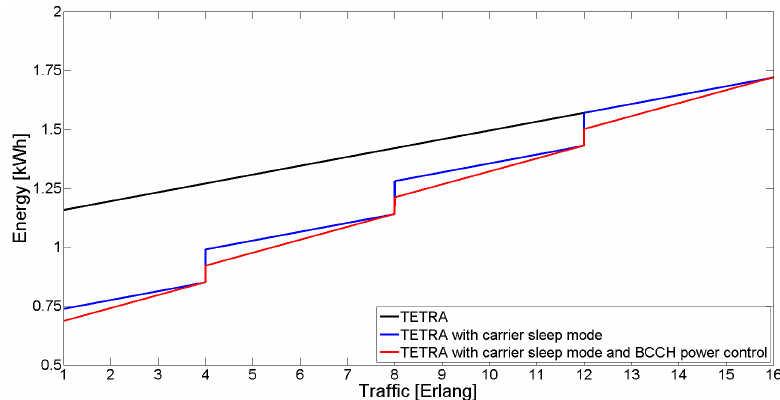
Figure 7. Energy consumption versus traffic for